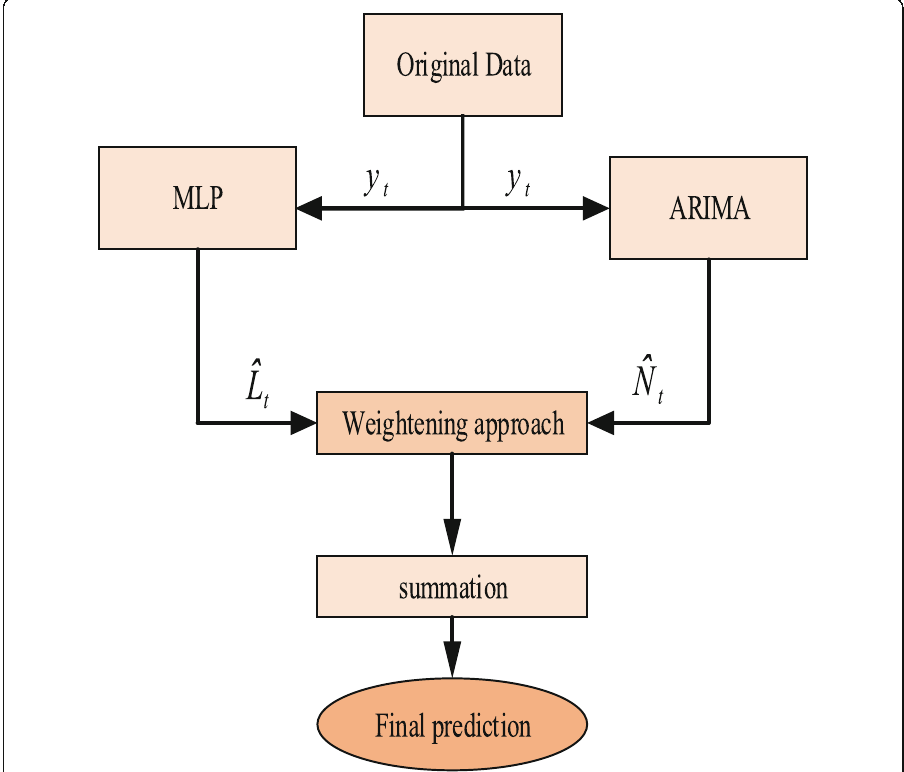
Fig. 3 Framework of parallel hybrid